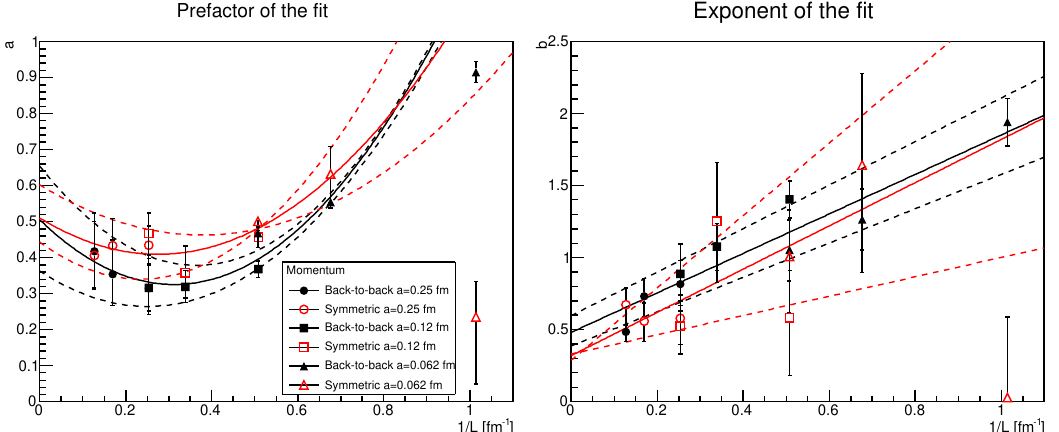
Figure 7: The fit parameters of (4) in 4 dimensions, together with a fit for the volume dependence. For the prefactor the fit is quadratic in the inverse lattice extent, and linear for the exponent. The smallest volume was dropped in the